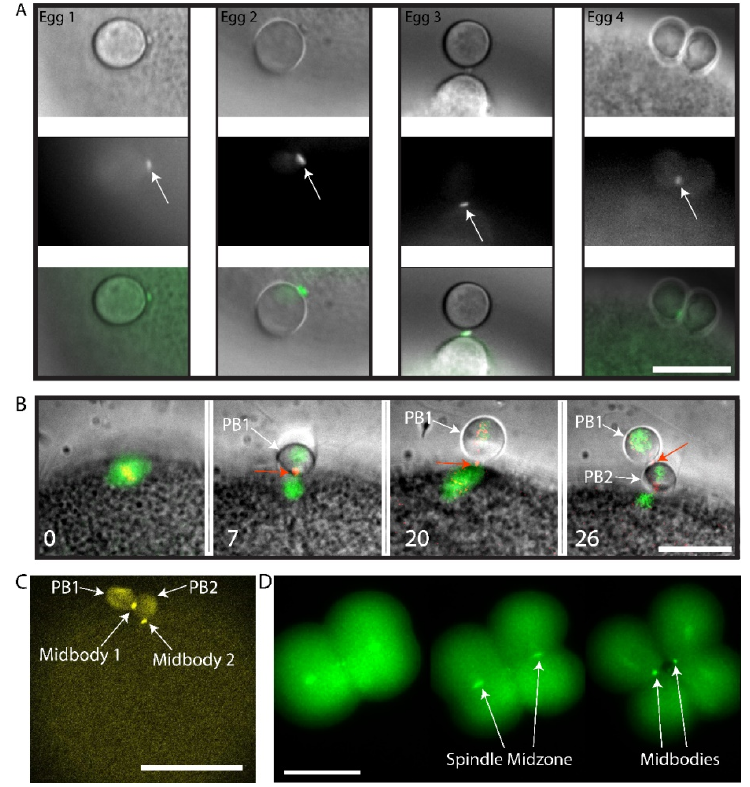
Figure 2. Plk1::Venus labels the midbody that forms between PB1 and the egg. ( A ) Four different examples of the small polar corps labelled with Plk1::Ven. Upper row of images shows bright field images of PB2 emission site adjacent to PB1. Middle row of images shows that Plk1::Ven labelled the midbody that formed between PB1 and the egg (see arrows). Bottom row is the overlay. Plk1::Ven localization to the midbody during the process of PB2 emission (see arrows). n = 12 / 12. Scale bar = 20 µ m. ( B ) Epifluorescence images of meiotic spindle labelled with EB3::3GFP and the midbody with Plk1::Rfp1. Please note that Plk1::Rfp1 labels the chromosomes (red) on the Meta I spindle (first image), then the midbody (second image) and also that the midbody is found at the apex of the PB2 outpocket (third image). PB1 is tethered to PB2 (fourth image). First midbody is indicated with red arrows and PBs are indicated by the white arrows. Time in minutes is indicated. Scale bar = 20 µ m. n = 5 / 5 from time-lapse experiments. ( C ) Fertilized egg after PB1 and PB2 emission. One confocal plane from a z-stack showing the localization of Plk1::Ven to midbody 1 and midbody 2 (arrows). PB1 and PB2 are also indicated by arrows. n = 12 / 12. Scale bar = 50 µ m. See Supplementary Movie S3. ( D ) Two to four cell-stage. Epifluorescence images of midbody formation. Plk1::Ven labels the central spindle (arrows) then both midbodies (arrows) at the end of cytokinesis. n = 22. Scale bar = 50 µ